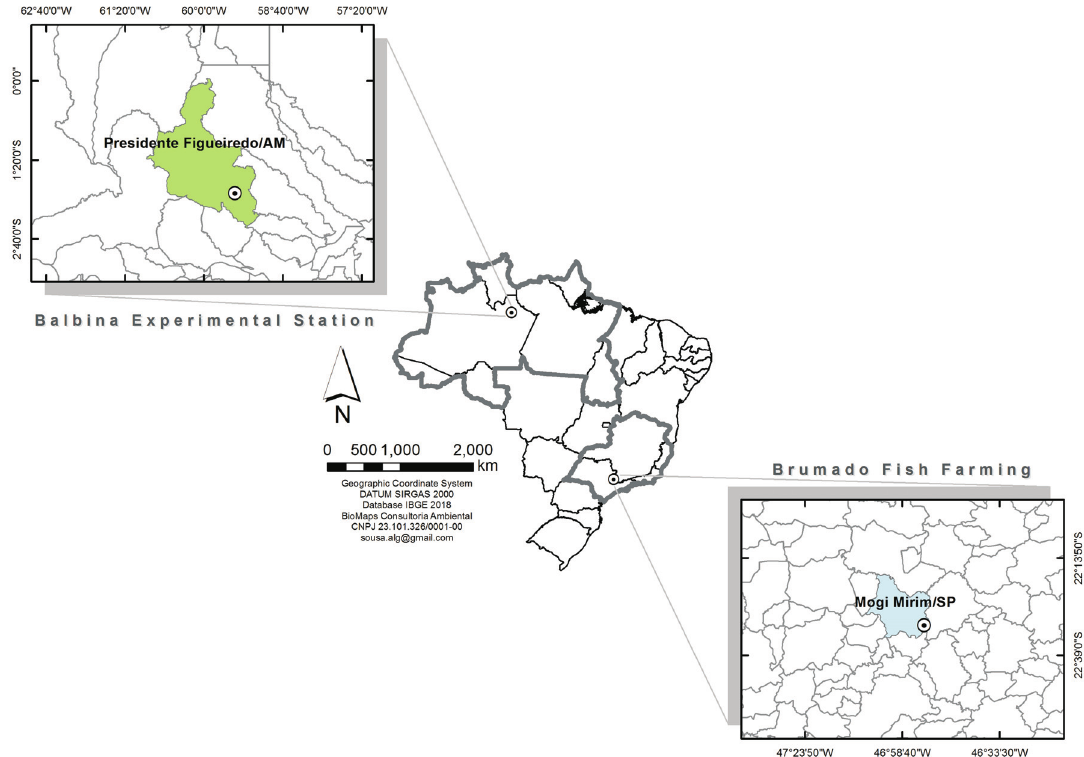
Figure1 -MapofthesamplingsitesoftwotambaquipopulationsfromdifferentregionsofBrazil.Thenorthern(BalbinaCenterofTechnology,Training and Production in Aquaculture, CTTPA – SEPA/SEPROR, Balbina, Amazonas state – 1°55’54.4"S; 59°24’39.1"W) and southeastern (Brumado